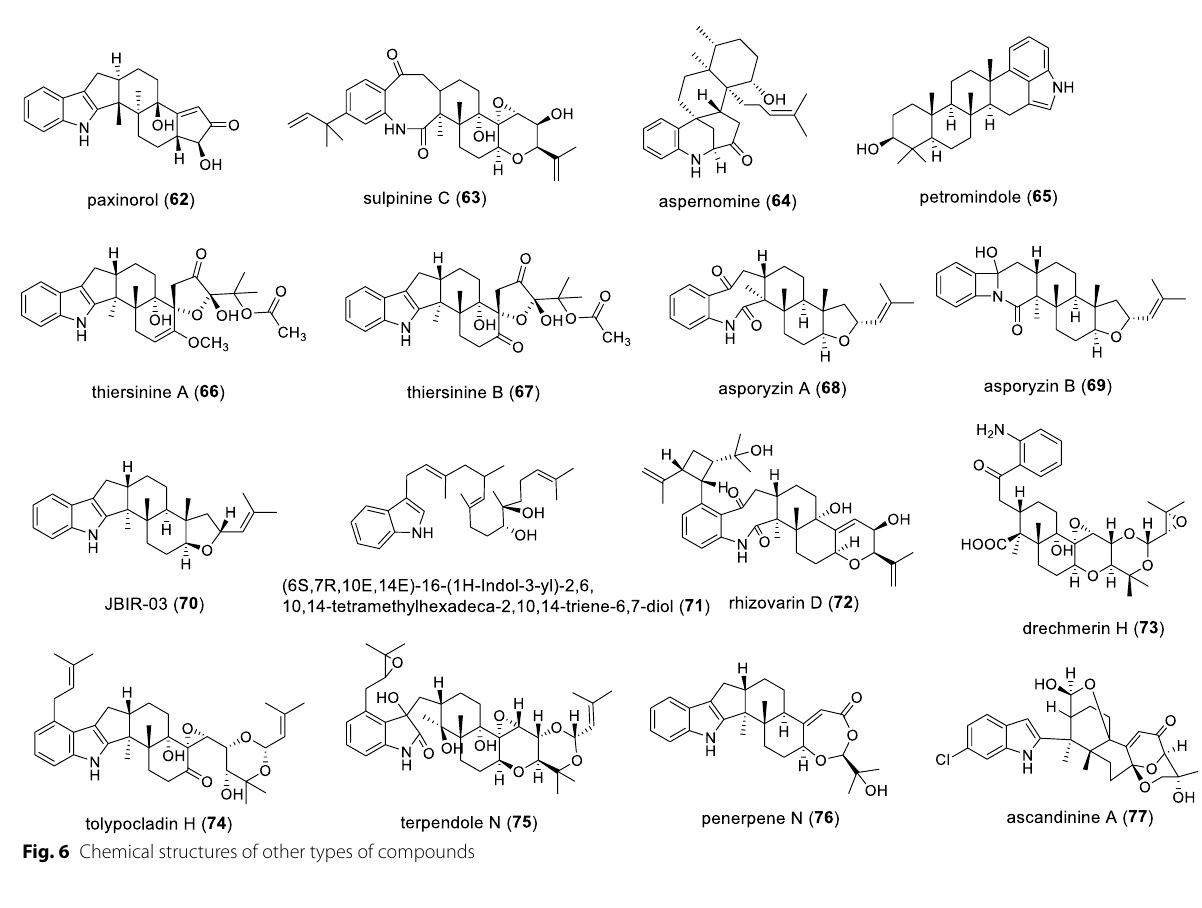
Fig. 6 Chemical structures of other types of compounds